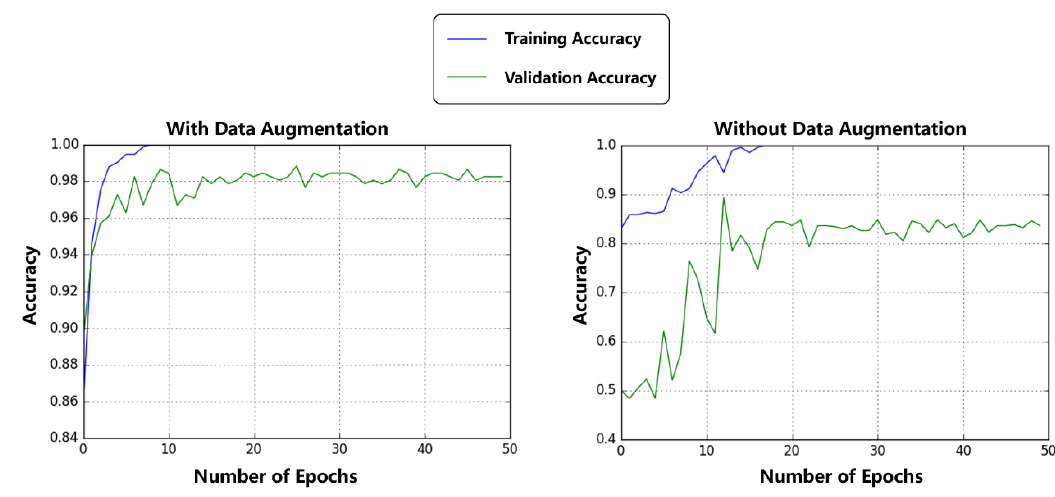
Figure 7. The training accuracy curve and validation accuracy curve of model training with and without data augmentation.